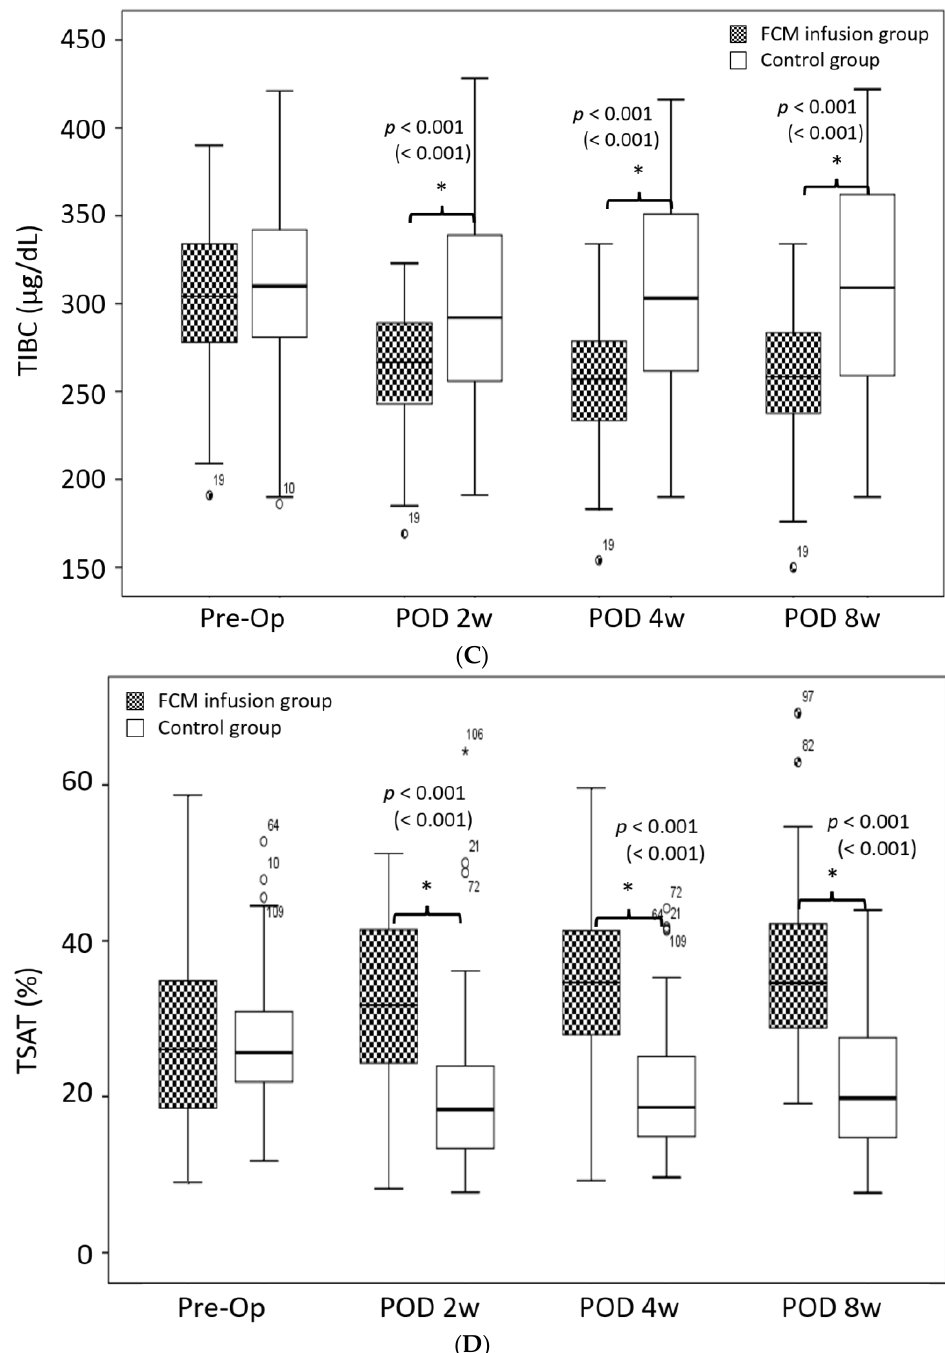
Figure 3. ( A ). Comparisons of the Ferritin level between the FCM and Control groups. ( B ). Comparisons of the serum iron level between the FCM and Control groups. ( C ). Comparisons of the TIBC level between the FCM and Control groups. ( D ). Comparisons of the TSAT level between the FCM and Control groups. The asterisks demonstrate a significant difference between groups. Band within the box = median; top and bottom of box = interquartile range (IQR); whiskers = values within 1.5 IQR of the top or bottom of the box; black and white circles with number = outliers in FCM group with case number indicating the case number; white circles with number = outliers in Control group with case number indicating the case number; and star = extreme outlier in each group. The p -values corrected by Bonferroni analysis are indicated, with the p -values before the Bonferroni analysis in parentheses. FCM: Ferric carboxymaltose; Pre-op: Preoperative; POD: Postoperative day; w: week; TIBC: total iron binding capacity; TSAT: transferrin saturation.